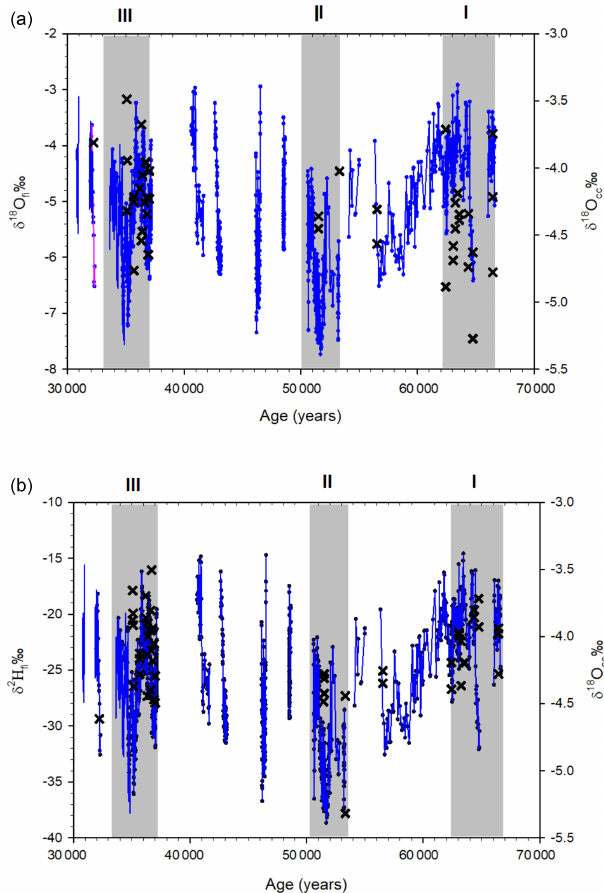
Figure 4. (a) Fluid inclusion oxygen isotope values ( δ 18 O FI ; black crosses) compared to calcite oxygen isotope values ( δ 18 O cc ; blue circles and line). (b) Fluid inclusion hydrogen isotope values ( δ 2 H FI ; black crosses) compared to δ 18 O cc (blue circles and line). Growth Phases I, II and III are shown as grey